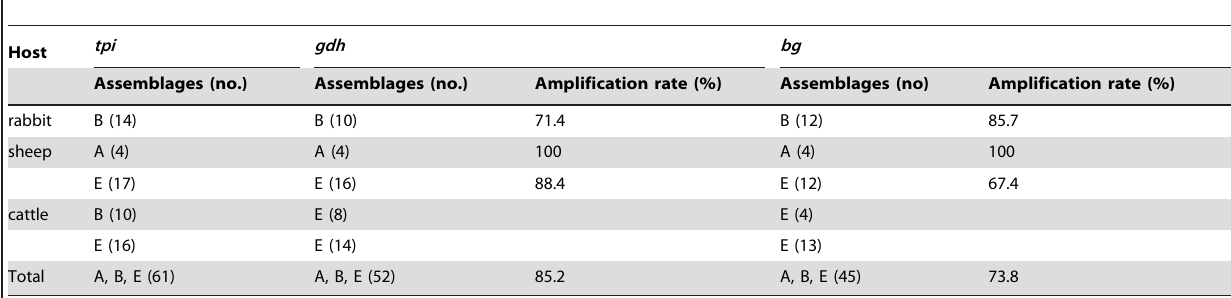
Table 1. PCR amplification rates of different G. duodenalis assemblages at the gdh and bg loci.